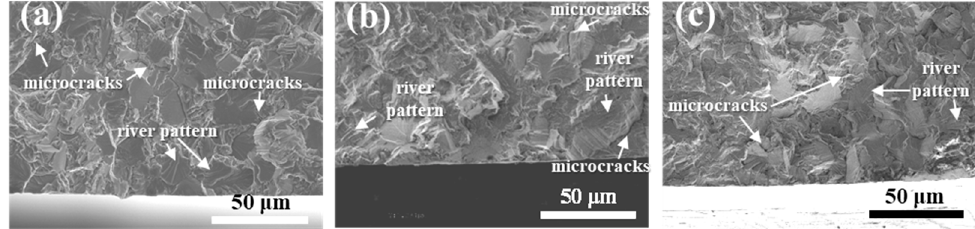
Figure 3. S-N curves of Ti64 samples subjected to different thermo-mechanical processing. Figure 4. SEM fractographs of samples at maximum cyclic stresses of 600 MPa: ( a ) FS (N = 1.03569 × 10 5 cycles), ( b ) RS (7.28959 × 10 5 cycles), and ( c ) HS (1.128265 × 10 6 cycles).